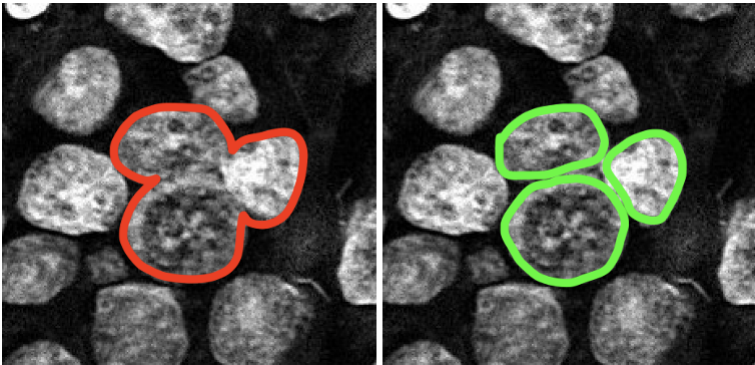
Figure 10. Wrong prediction ( left ) and correct prediction ( right ). Table 2. Comparison of SVM and Proposed U-net based nuclei detection results